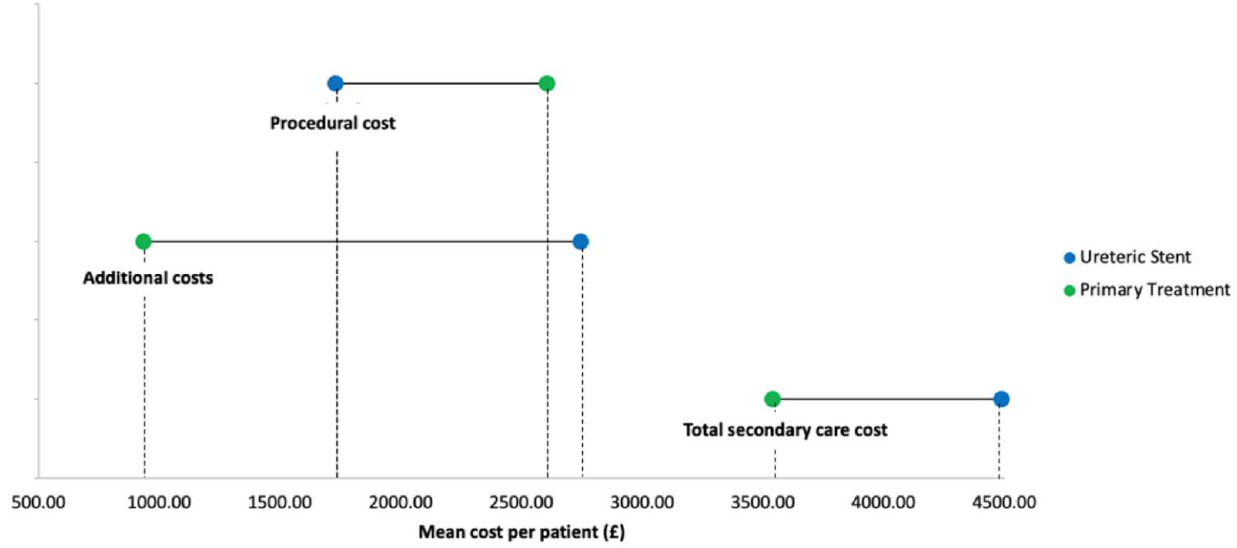
Figure 3. Summary of cost